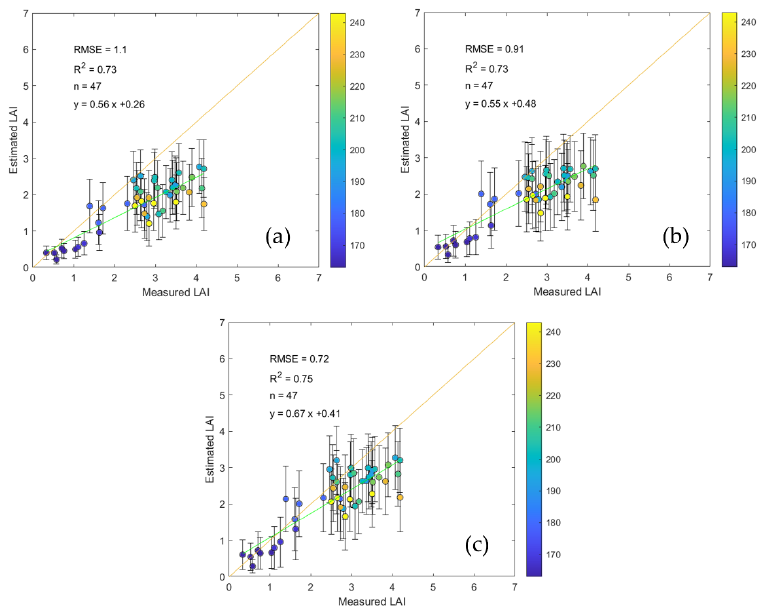
Figure 8. Comparison of estimated and measured LAI using VI-based LUT for Landsat 7 / 8. The VIs used for inversion correspond to ( a ) NDVI; ( b ) EVI2; ( c ) CIgreen. Error bar represents the standard deviation of LAI retrievals. Color bar represents DOY (i.e., day of year) of images. For Sentinel-2, four combinations of spectral bands and four VIs (see Table 3) were used to